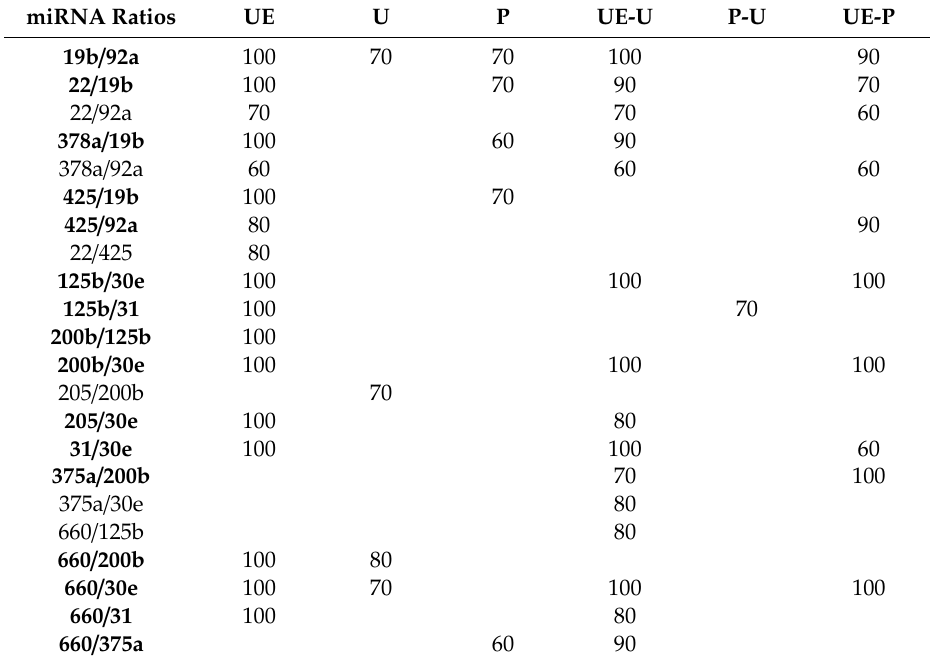
Table 5. ROC curve analysis: PCa vs. BPH, sensitivity at 100%